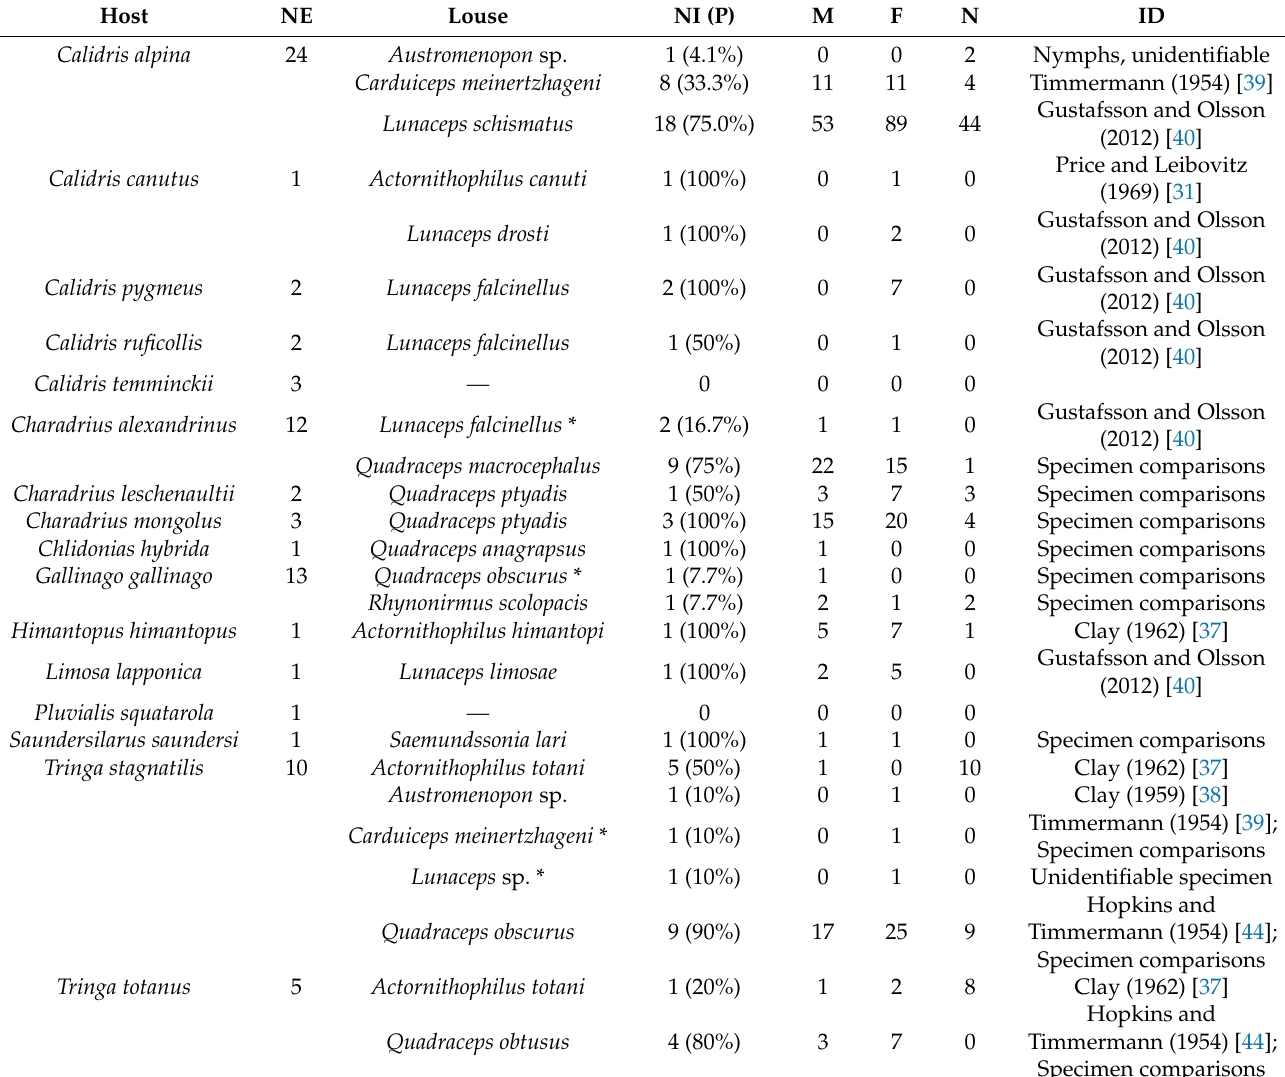
Table 2. Lice collected from shorebirds (Charadriiformes) in the Leizhou area, Guangdong Province, China, in 2020. Specimens marked with an asterisk (*) are presumed to be stragglers. All col- lected species of chewing lice constitute new records for China. Abbreviations used: F = females; ID = resources used for identification of lice; M = males; N = nymphs; NE = number of hosts exam- ined; NI (P) = number of hosts infested (prevalence). No lice were obtained from Calidris temminckii and Pluvialis squatarola , which we signify with dashes